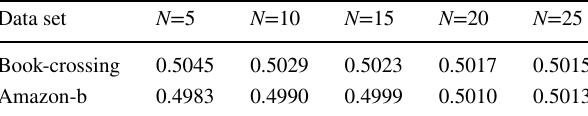
Fig. 6 F1 for Book-crossing and Amazon-b data sets Table 7 Reward for online mode Data